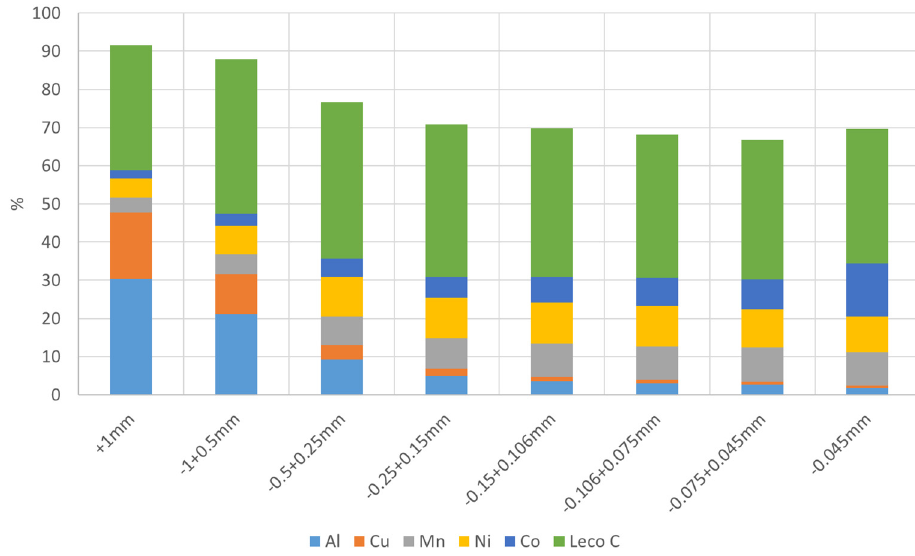
Figure 2. Distributions of elemental contents in size fractions.